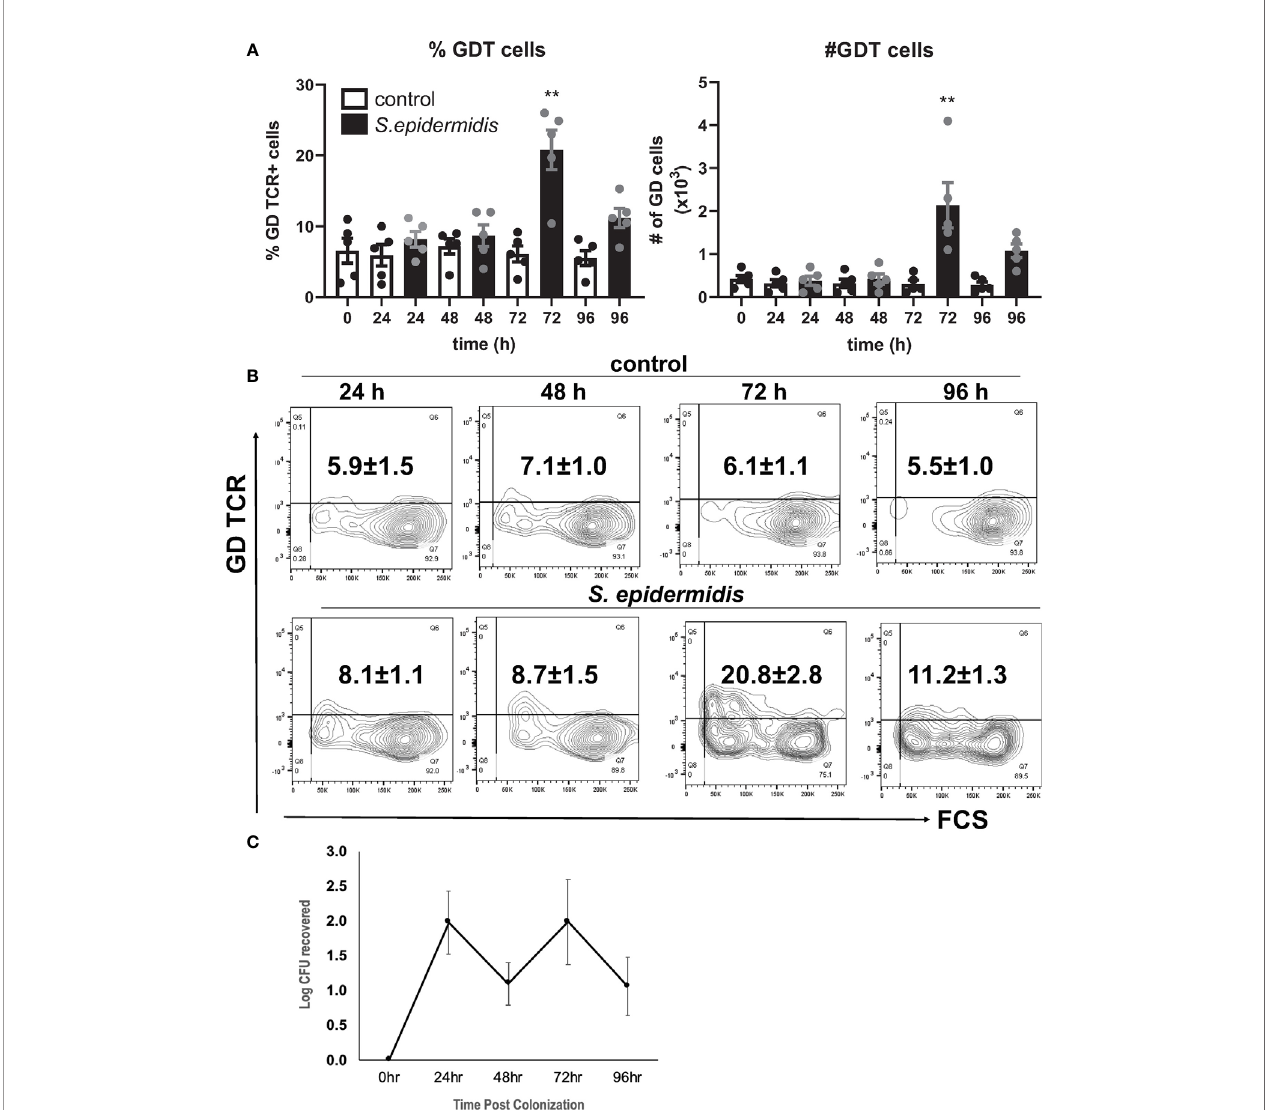
FIGURE 1 | Staphylococcus epidermidis increases the number of GD T cells in human skin ex vivo. Control, uncolonized, and S. epidermidis colonized skin was maintained on air liquid interface and collected at indicated time points (0, 24, 48, 72, and 96 h). Single cell suspensions were obtained and labeled with live/dead stain, CD45, CD3, and GD TCR. (A) Cells were analyzed using fl ow cytometry and gated on the CD45+ CD3+ GDT+ population. Bar graphs show SEM frequency (%) and SEM number (#) of skin GD T cells (n = 5). (B) Representative contour plots showing frequency of GD TCR in control and S. epidermidis colonized skin. (C) Number of S. epidermidis colony forming units (CFU) recovered from ex vivo skin explants colonized with S. epidermidis CCN021 on day 0 through day 4. Data represent at least two technical replicates and fi ve independent biological replicates per group. **p < 0.01 (two-way ANOVA with Holm-Sidak multiple- comparison